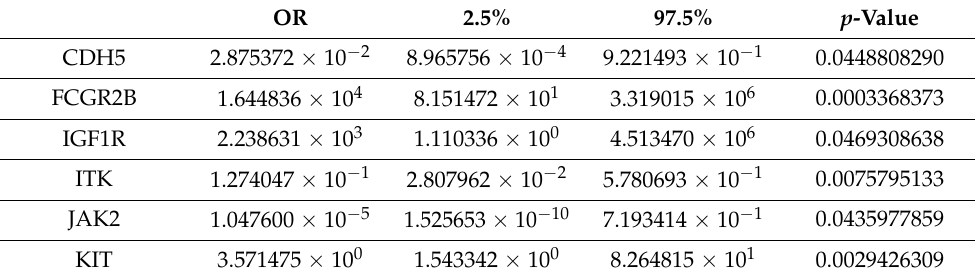
Table 2. Odds ratios and confidence intervals for significant genes.